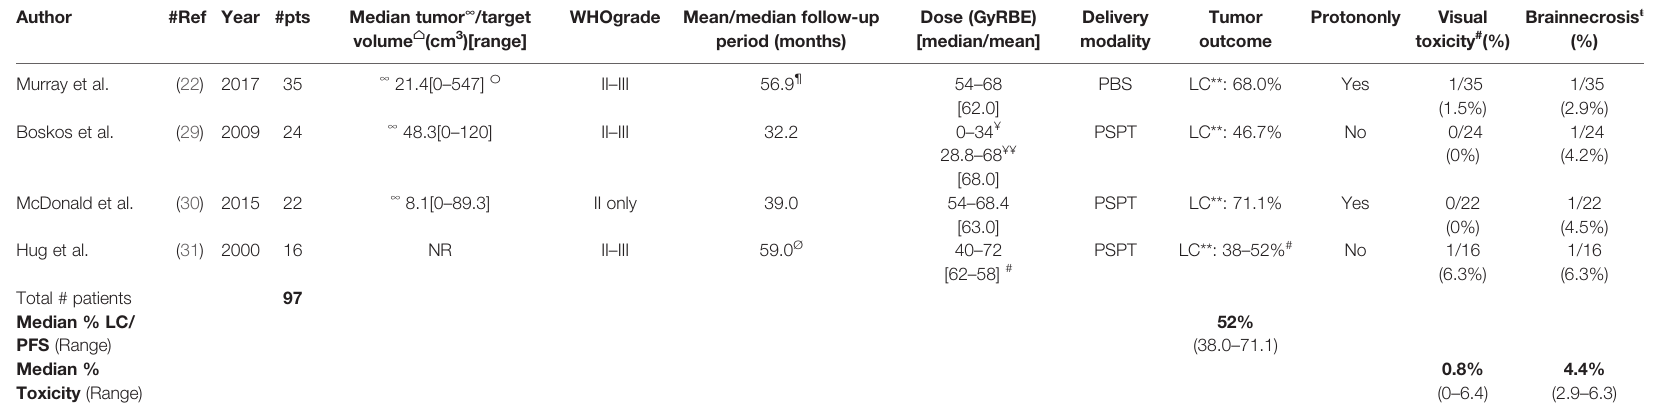
TABLE 2 | Pencil beam scanning or passive-scattering photon/proton therapy delivered to presumed or histologically-proven WHO grade II-III tumors.